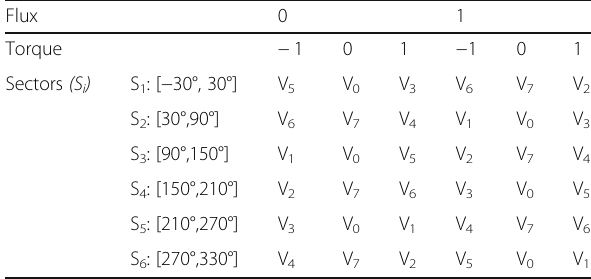
Table 1 Switching states of the two-level inverter